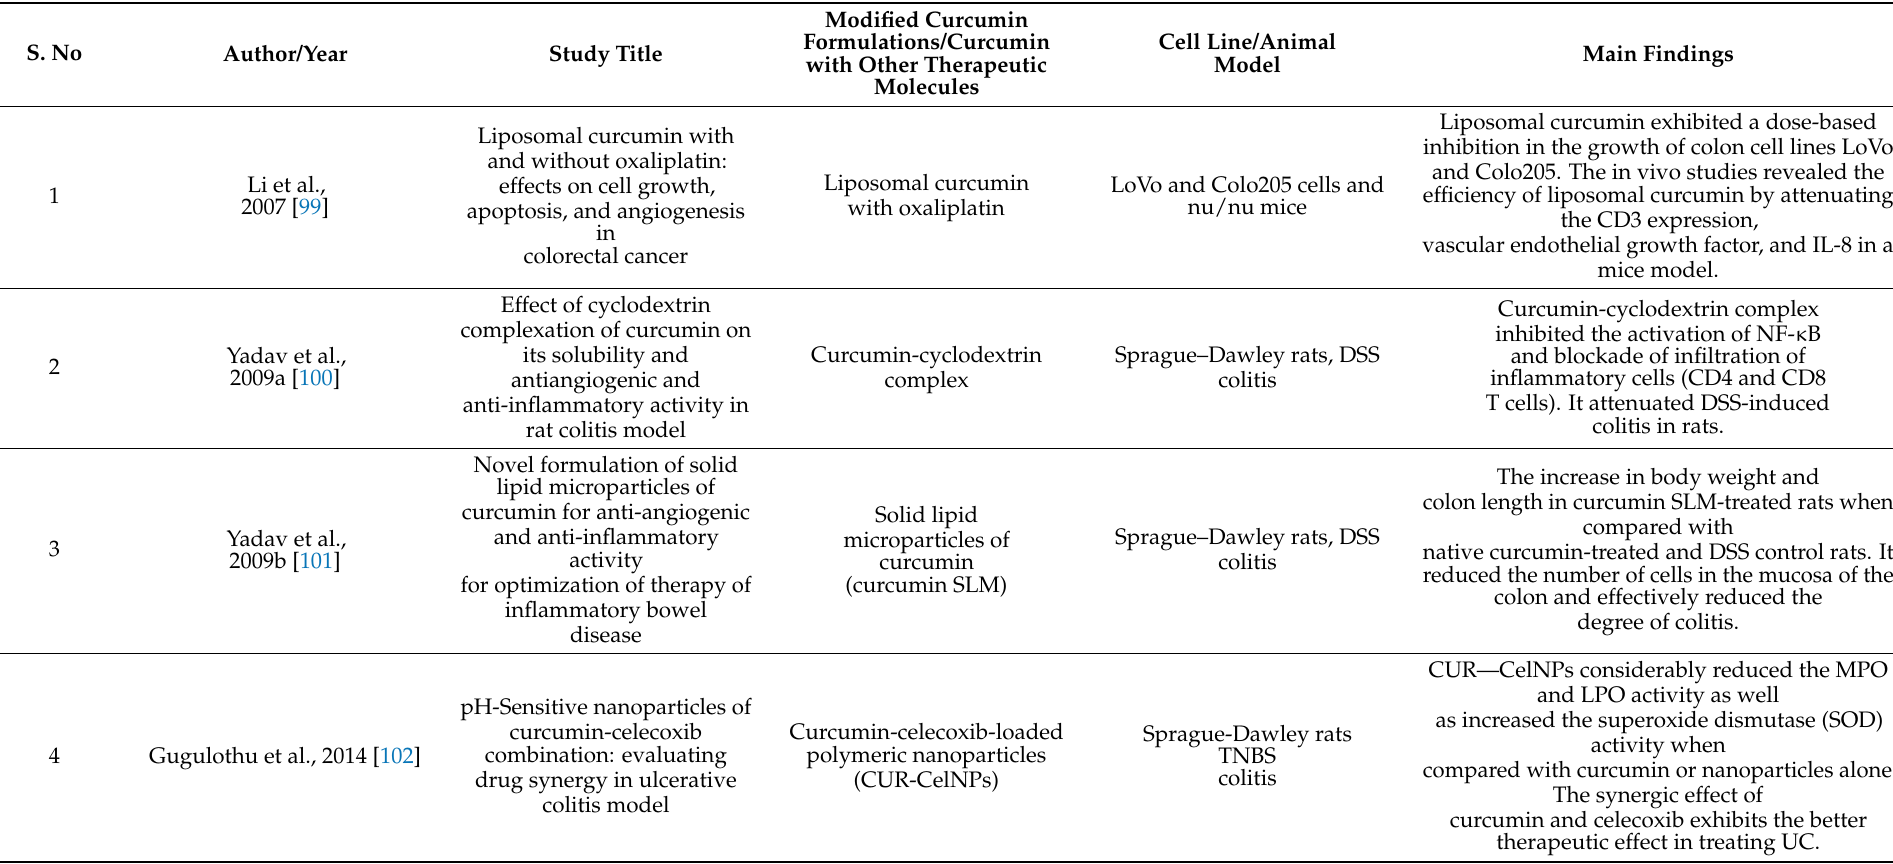
Table 4. Details of in-vitro and animal studies of curcumin combinations with other therapeutic molecules and modified curcumin formulations administration in inflammatory bowel disease